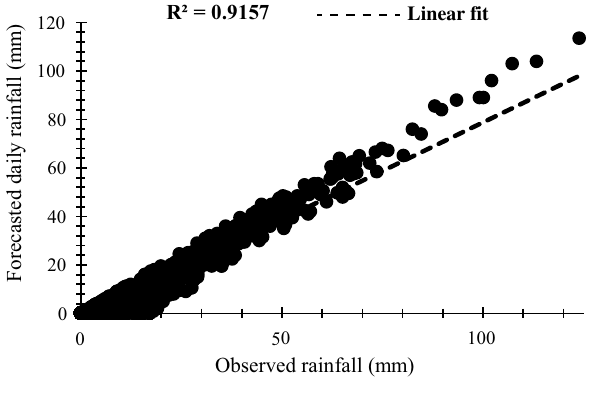
Fig. 3 Linear evolution of the deterministic forecast and